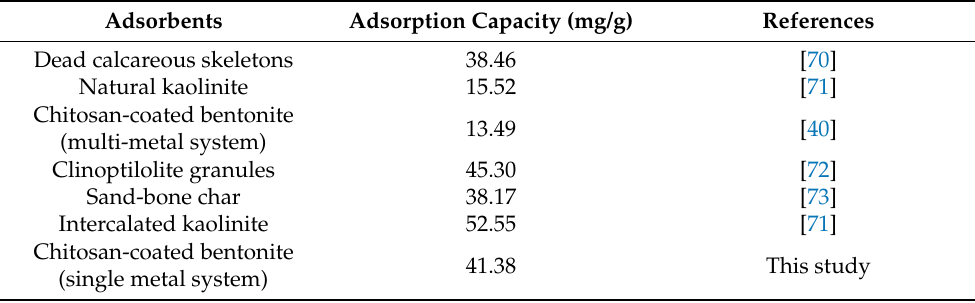
Table 4. Comparison of adsorption capacities of various adsorbents in the removal of Pb(II) using fixed-bed